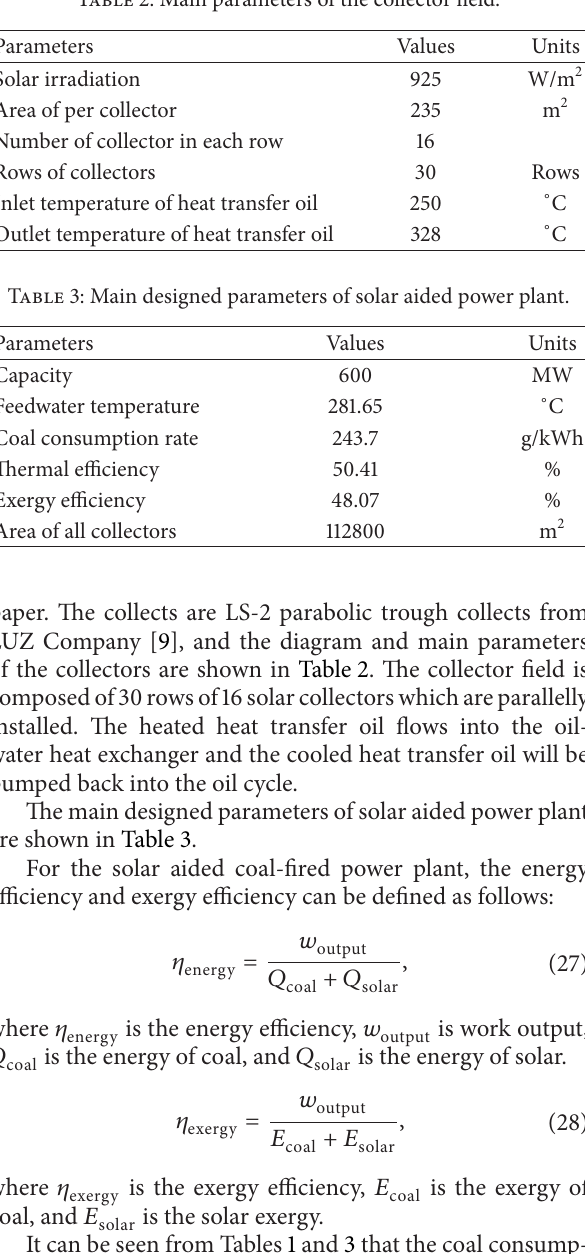
Table 2: Main parameters of the collector field.